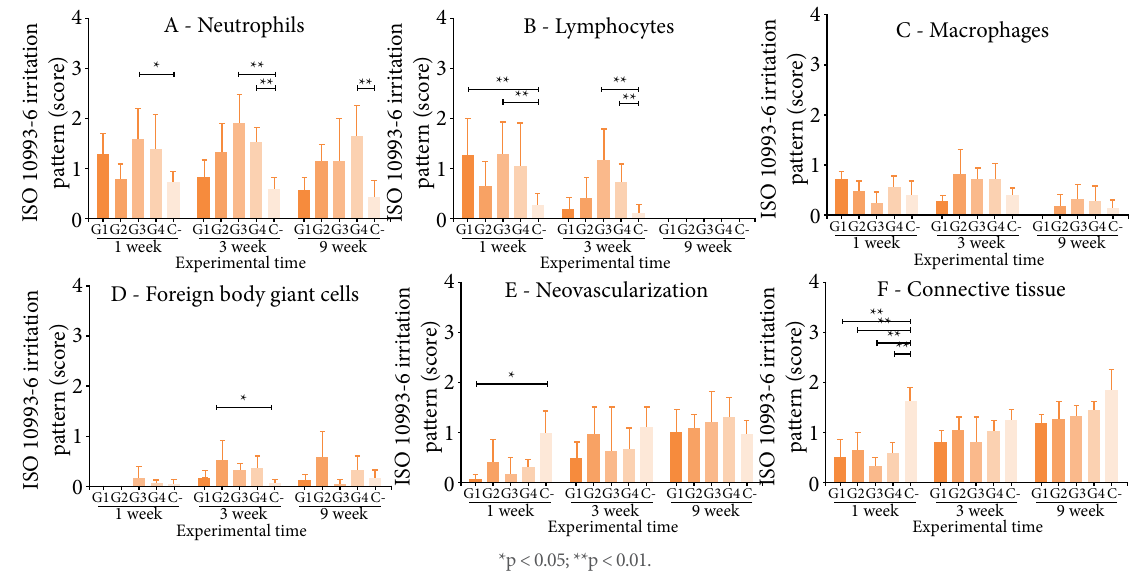
Figure 4 - Inflammatory pattern and repair pattern of poultry collagen-based hydrogels in subcutaneous tissue in mice at one, three and nine